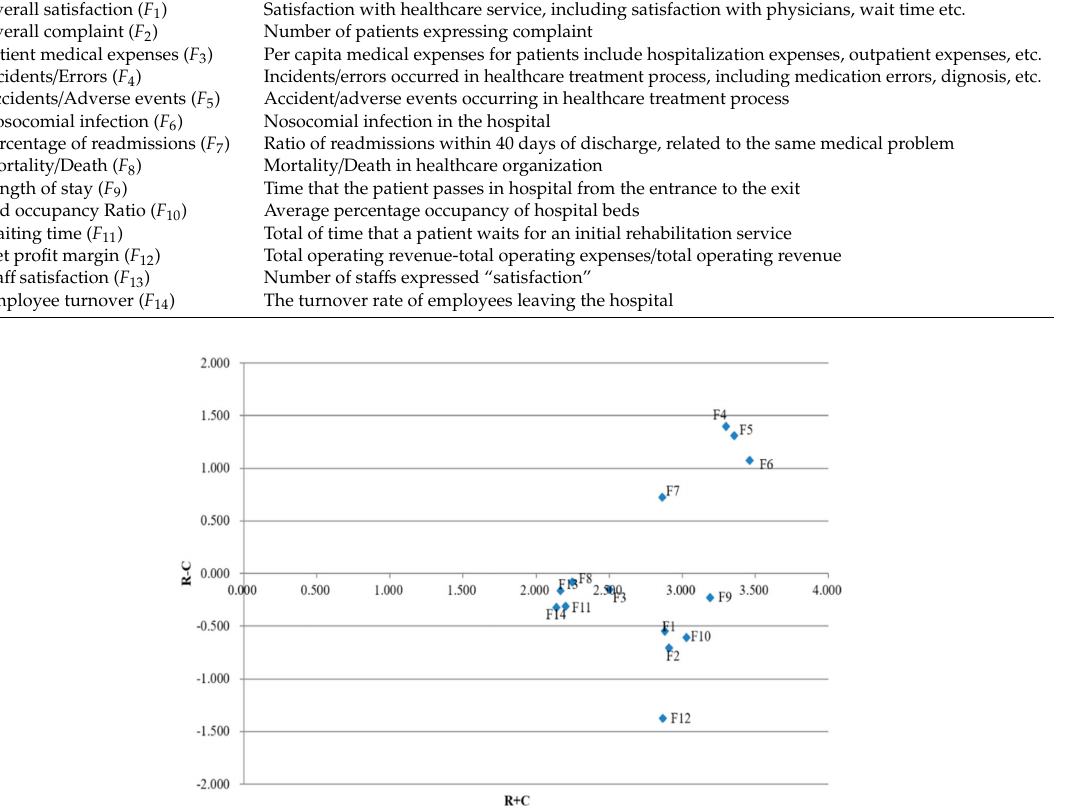
Figure 2. Causal diagram of the